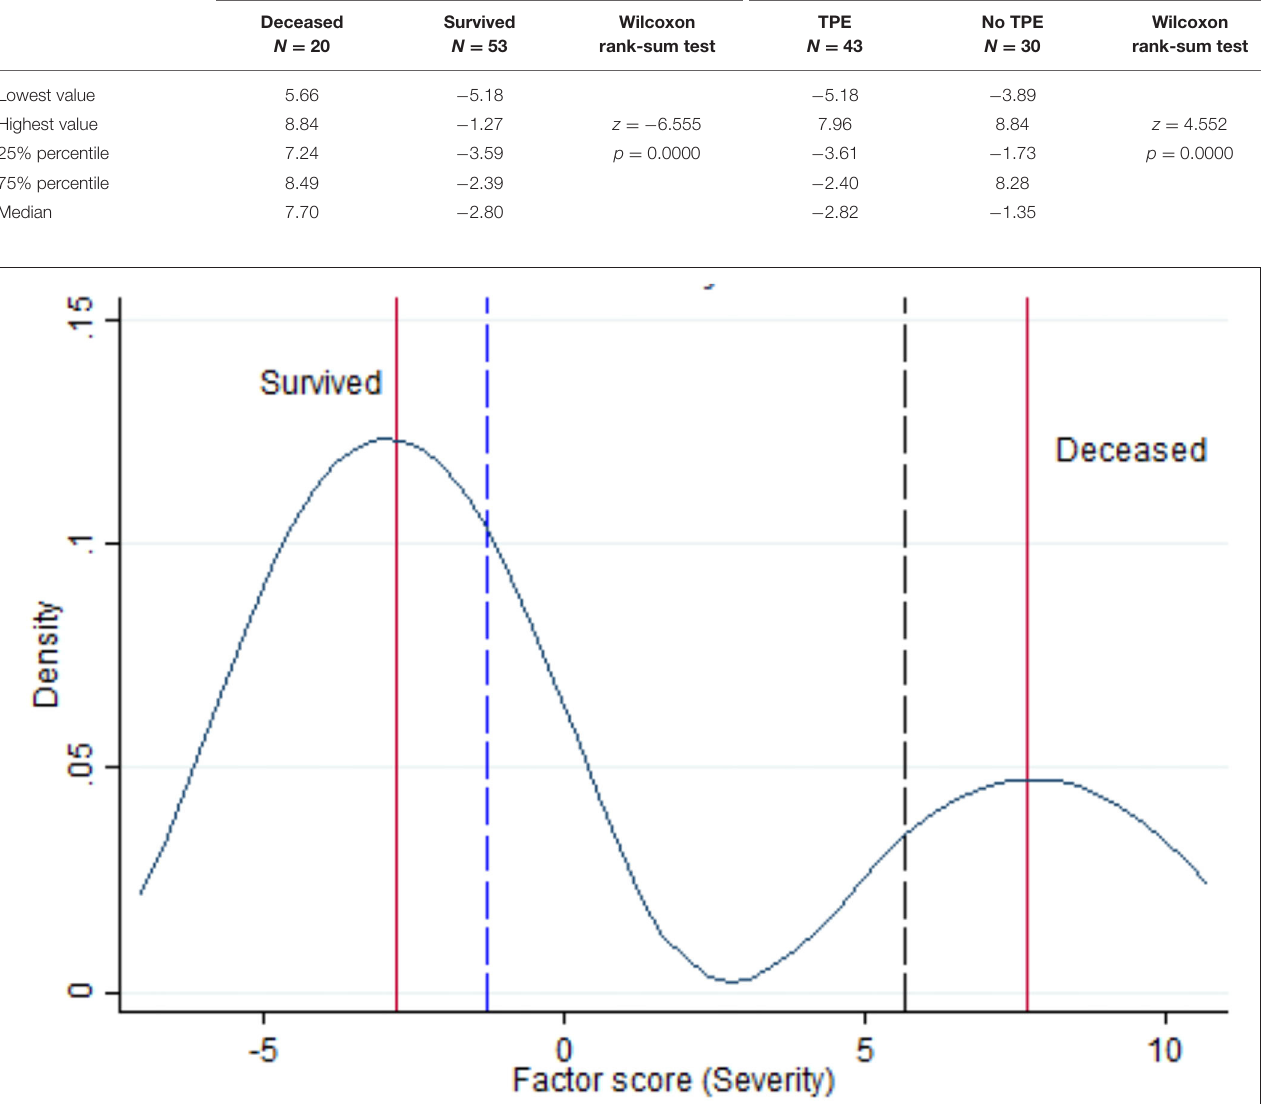
FIGURE 2 | Kernel density estimate for the latent variable “Severity” with vertical lines indicating the median of survived and deceased (red lines), the lowest range of Severity in survivors (blue dashed vertical line) and the highest range of Severity among deceased (black dashed vertical